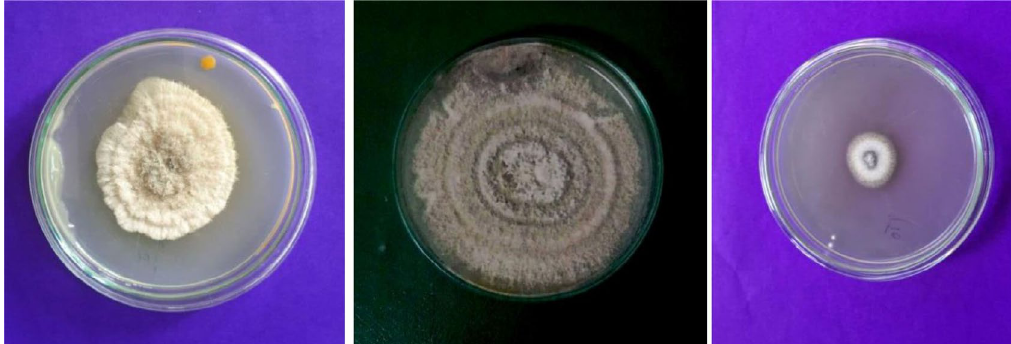
Fig. 2. Colony morphology of endophytic fungi.